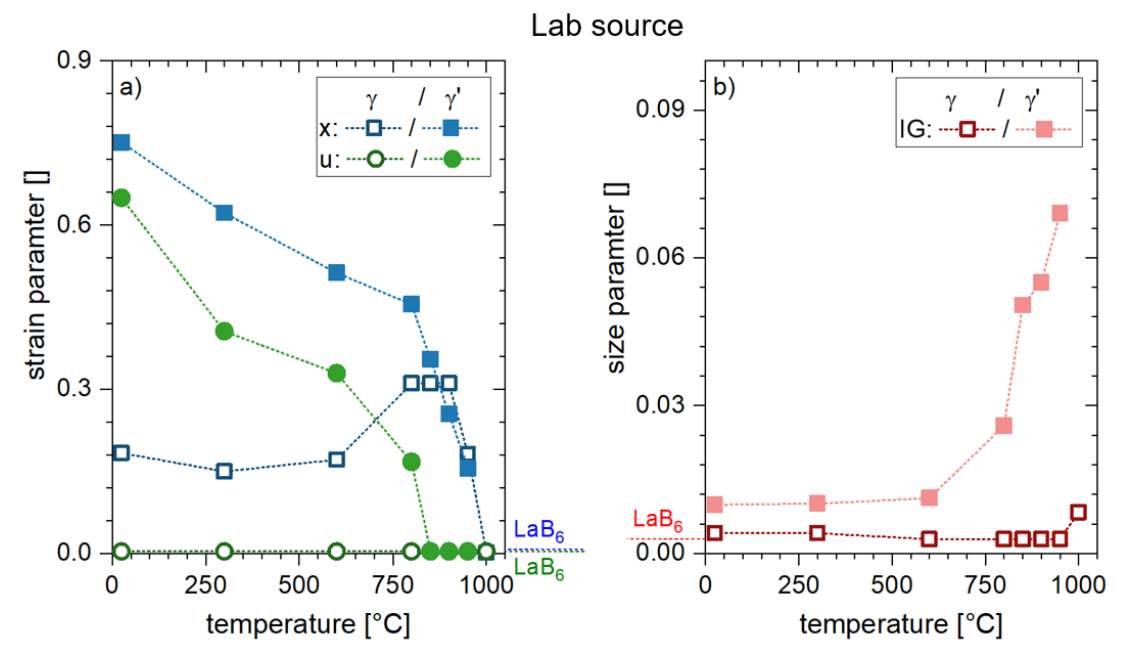
Figure 9. Evolution of ( a ) the strain parameter (u, x) and ( b ) the size parameter (IG) with rising testing temperature for the lab-source XRD experiments. The dashed lines next to the diagrams indicate the instrumental strain and size parameter, which were measured by LaB6. A higher strain or size parameter may be related to an increasing lattice strain or decreasing crystallite size, respectively.